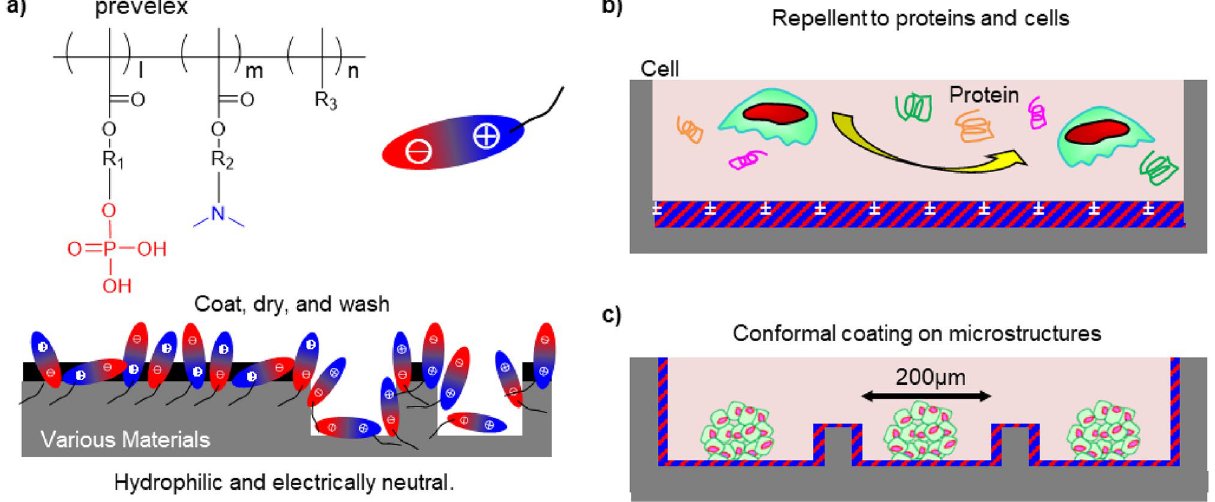
Figure 1. Coating with prevelex and its use for cell aggregate culture. ( a ) Chemical structure of polyampholyte “prevelex” consisting of phosphate units and amine units. Thin polymer films are conformally formed on substrates via simple coating, drying, and washing processes, altering the surfaces to be highly hydrophilic and electrically neutral. ( b ) Prevelex-coated surface for resistance to protein and cell adhesion. ( c ) Spheroids formed in microwell array with conformal prevelex